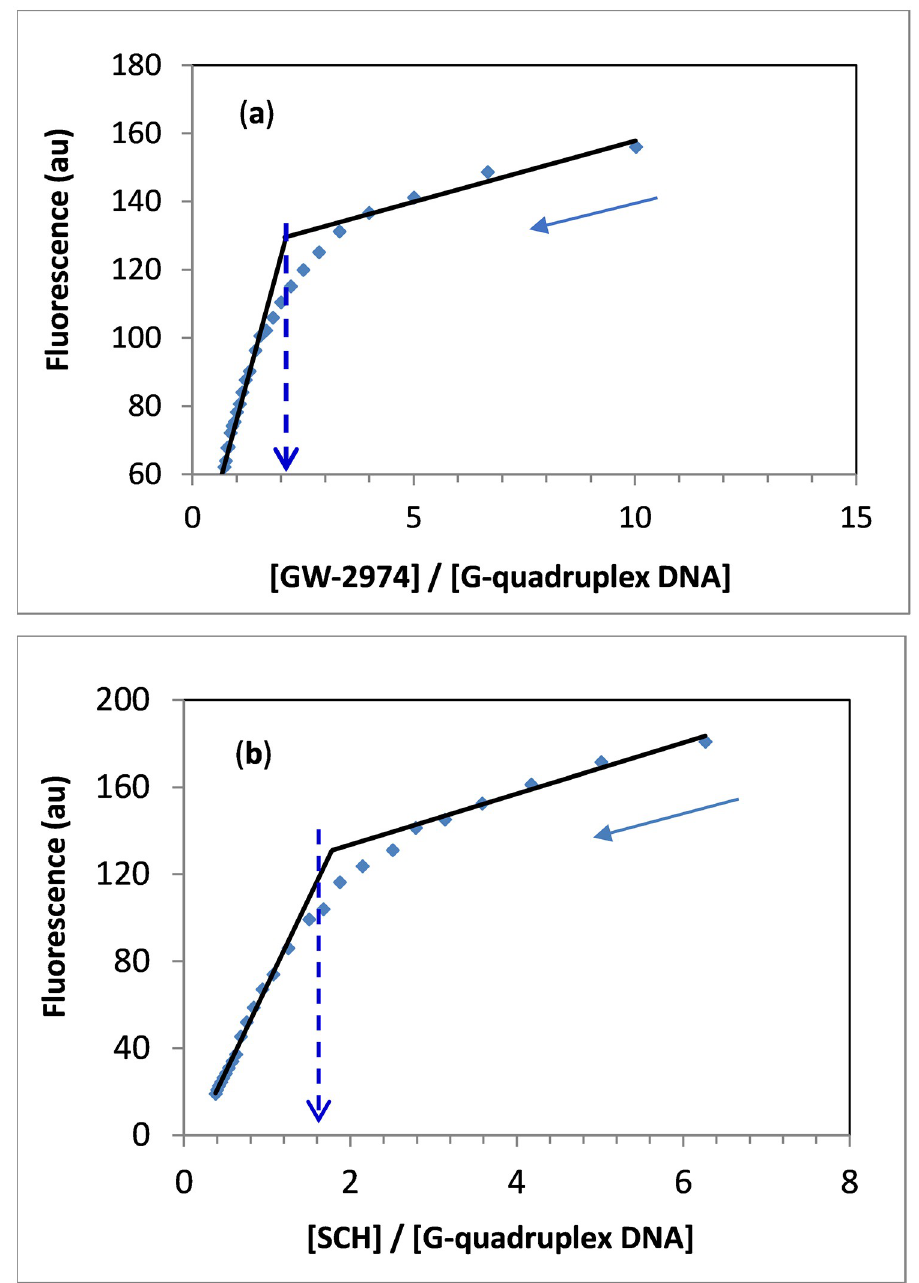
Fig 4. Stoichiometric ratio of [Drug]/{G-quadruplex DNA] using the molar ratio method. Hunan telomeric G- quadruplex DNA (1.44 × 10 − 5 M) was added in different increments to 2.0 ml of 5 × 10 − 6 M GW-2974 ( a ) or SCH- 442416 ( b ). Fluorescence emission of the two compounds was followed at 410 or 420 nm, respectively. Measurements were carried out in Tris–KCl buffer, pH